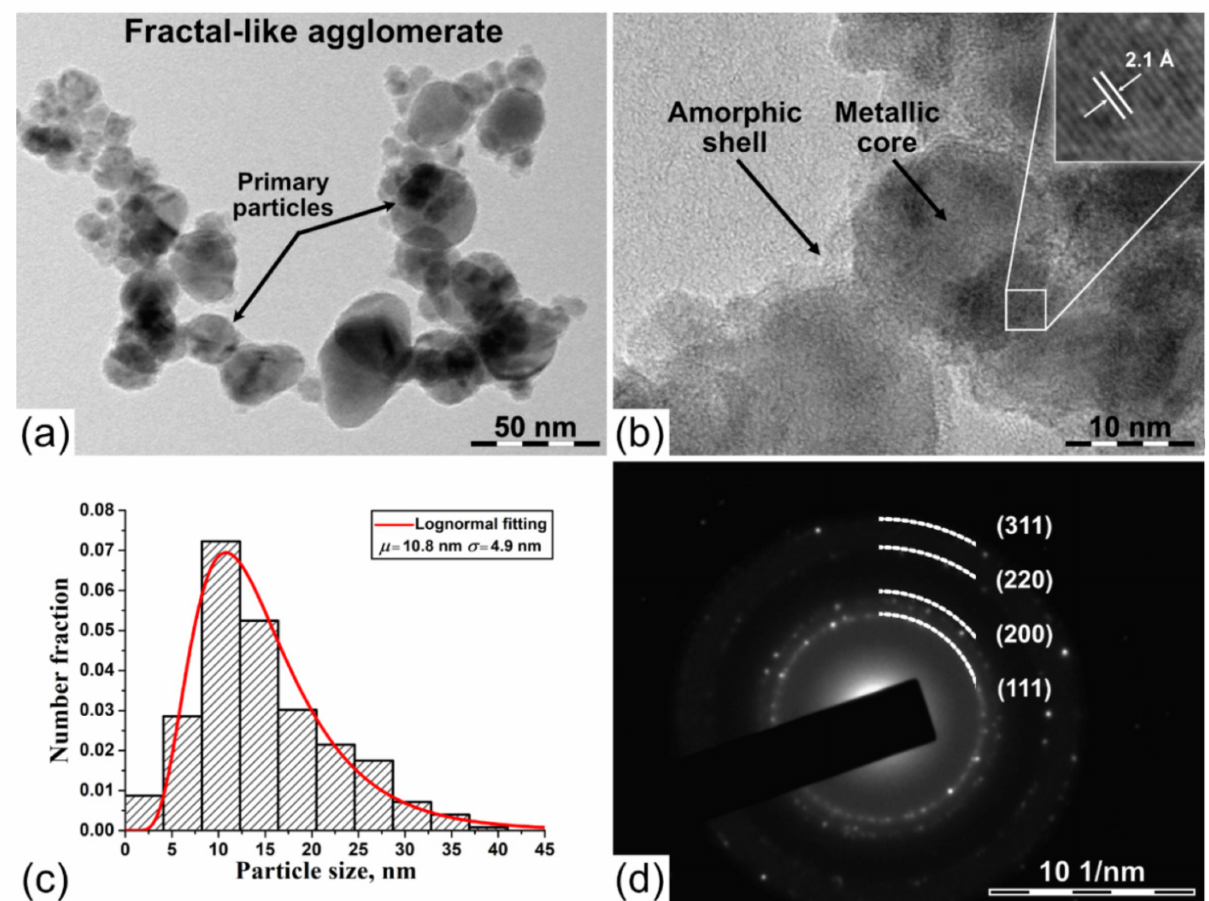
Figure 2. ( a , b ) TEM images of nanoparticles synthesized in a spark discharge by erosion of copper electrodes in an argon atmosphere with hydrogen (Ar 95% + H 2 5%) and the corresponding ( c ) particle size distribution and ( d ) electron diffraction